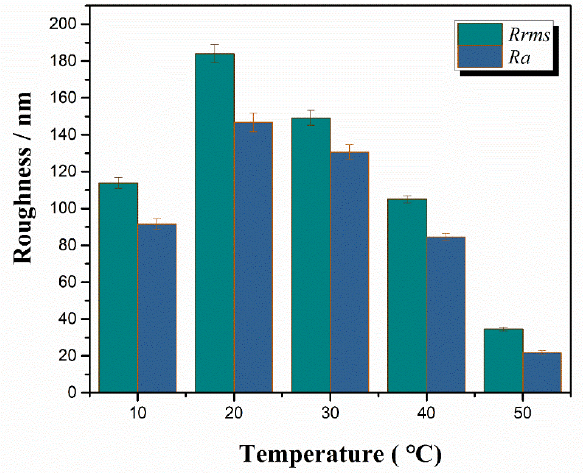
Figure 4. Root-mean-square roughness and average roughness of composite anodic films at different